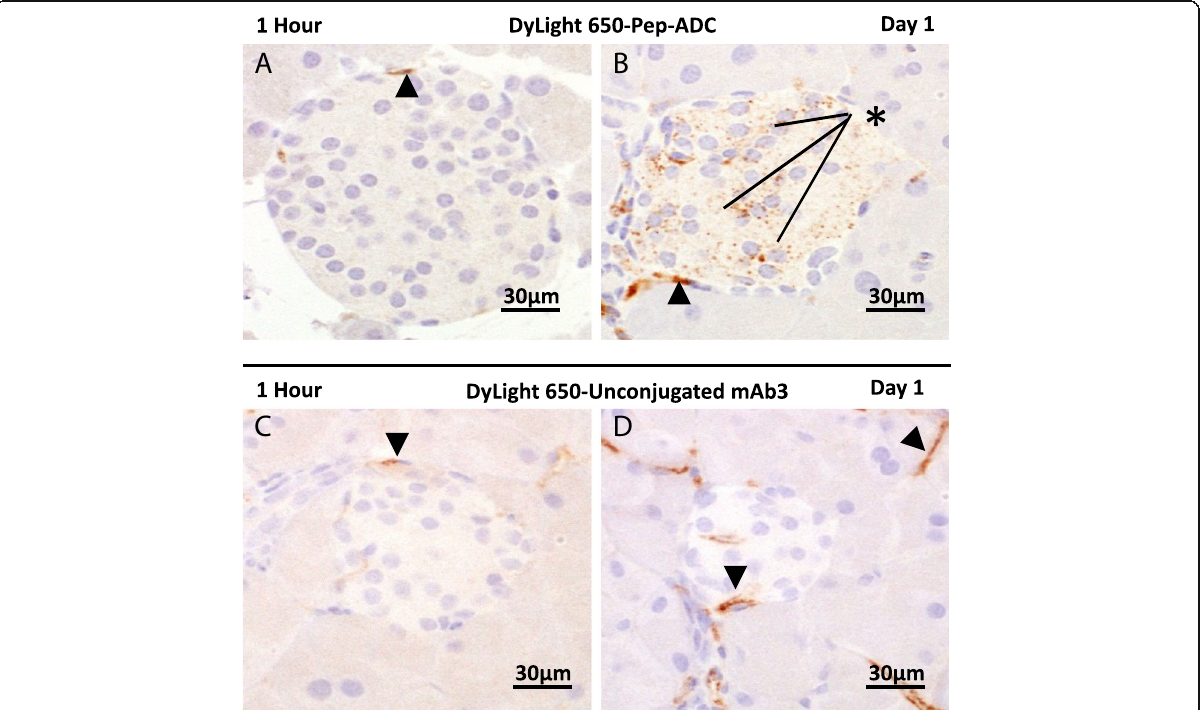
Fig. 14 Immunohistochemical analysis of cellular disposition of DyLight 650-labeled Pep-ADC ( a and b ) and Dylight 650-labeled unconjugated mAb3 ( c and d ). Tissue sections were stained with anti-DyLight 650 dye specific antibody. Asterisk (*) represents Pep-ADC localized to pancreatic Islets of Langerhans at Day 1. Arrowheads show labeling of capillaries with both